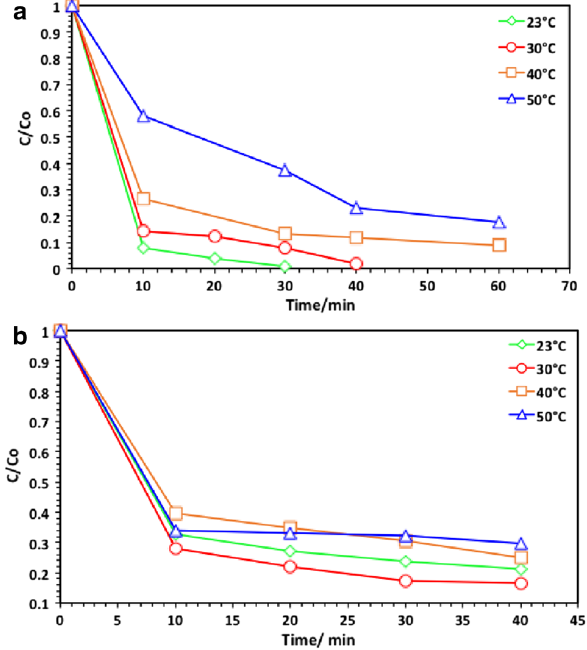
Fig. 9 Effect of different reaction temperatures on a LFR (Dye 100 mg/L; H 2 O 2 800 mg/L; AS400 1 g/L; pH 3.0) and b LA (Dye o 50 mg/L; H2O2 800 mg/L; AS400 1 g/L; pH 3.0) azo-dyes removal during oxidation for different time (